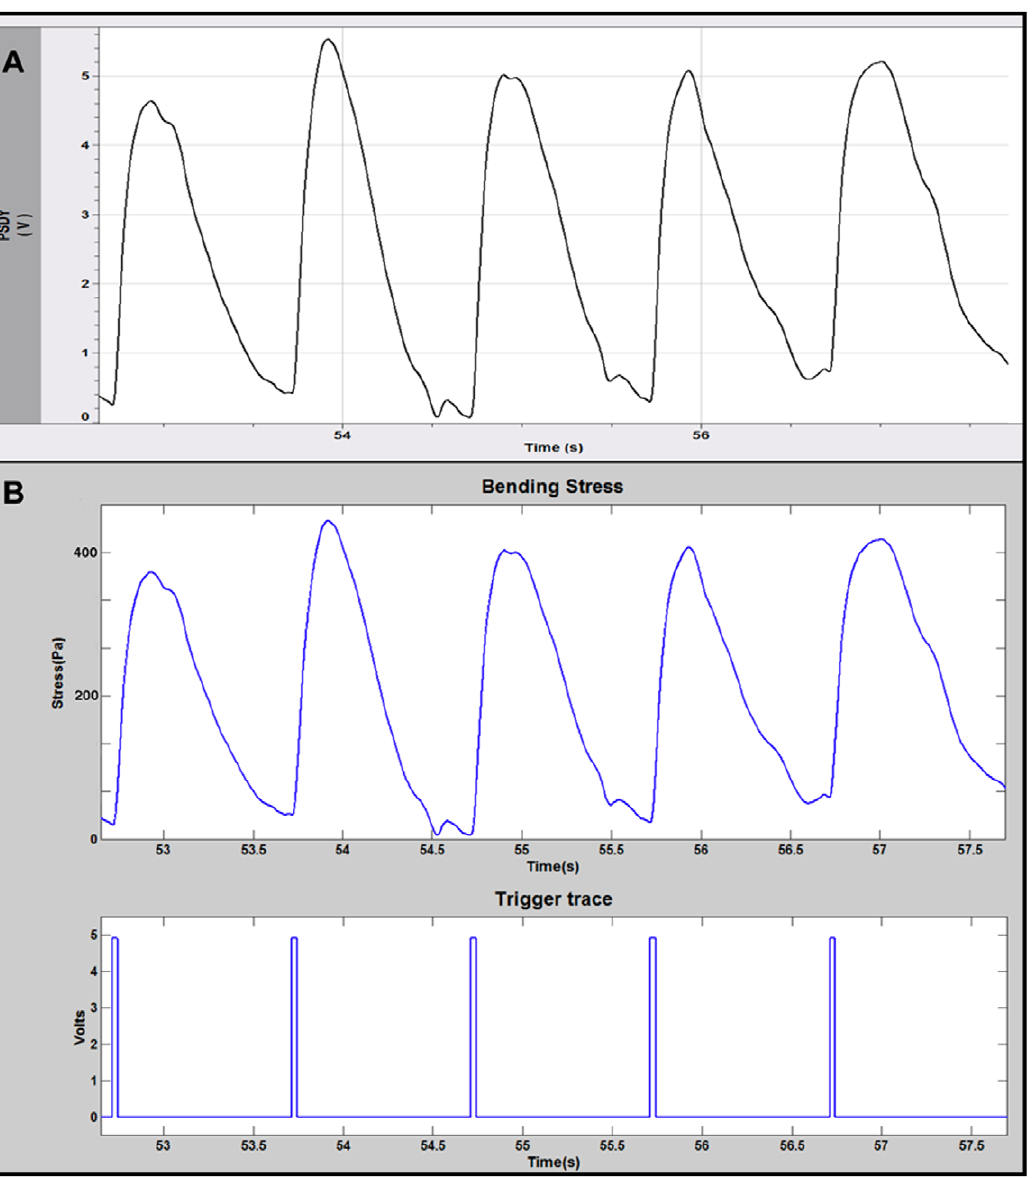
Figure 4. Stress calculation using the modified Stoney’s equation. A) Raw data measured from the cantilever deflection system. B) Estimated stress calculated using the modified Stoney’s